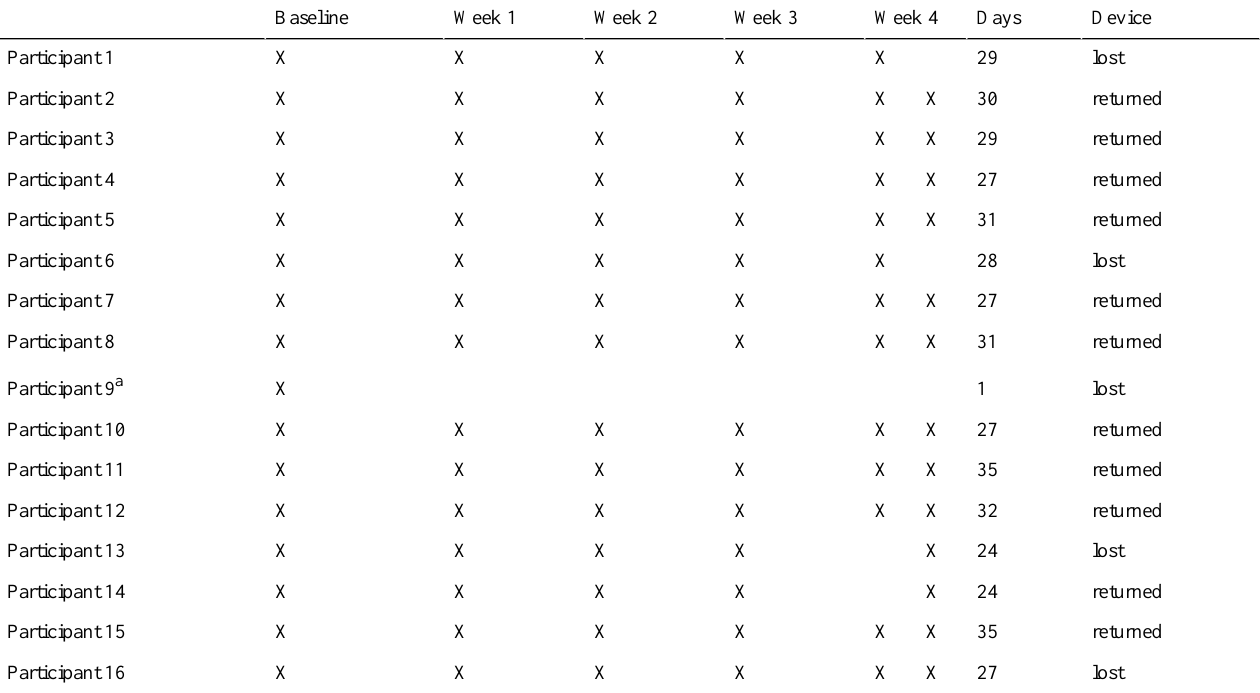
Table 3. Days of follow-up and device loss (participants were enrolled in 6 waves of data collection [2-3 participants/wave]. Phone was reused in each wave. Once a phone was lost, a replacement phone was